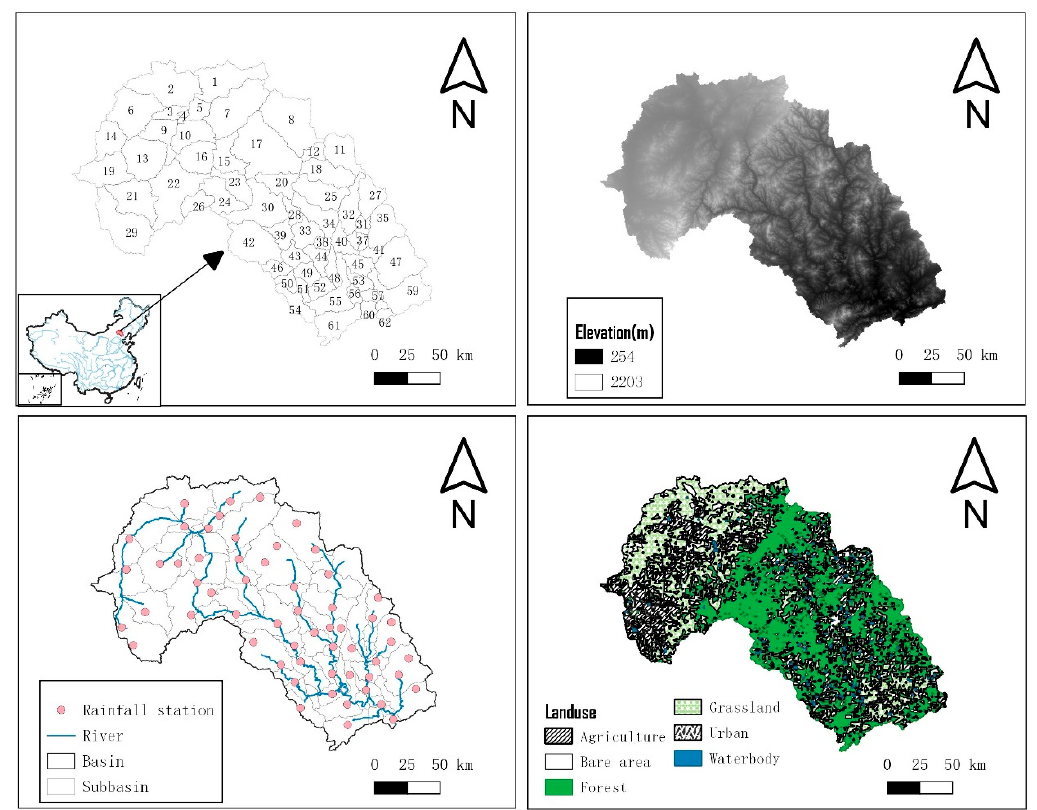
Figure 1. Location, sub-basins, land-use distribution, and elevation of the Luanhe watershed.